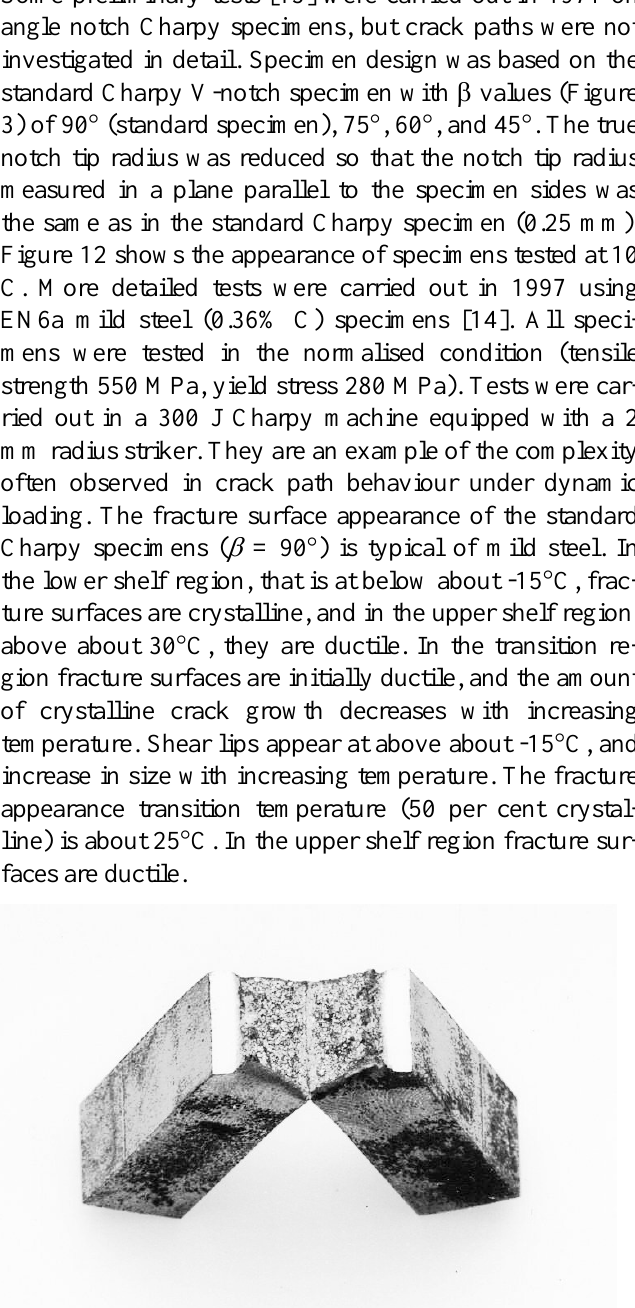
Figure 13. Angle notch Charpy specimen, abrupt transition to crystalline crack